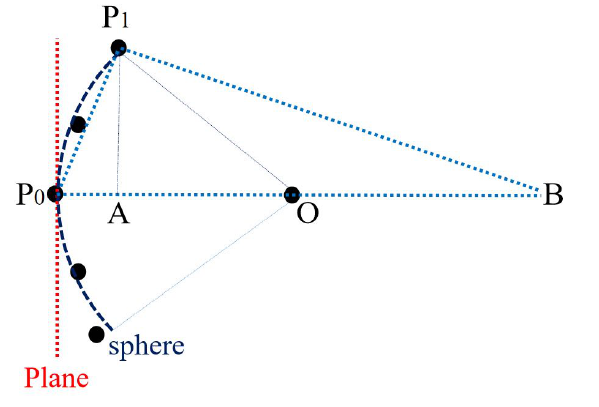
Figure 4. The competition between planar and curved